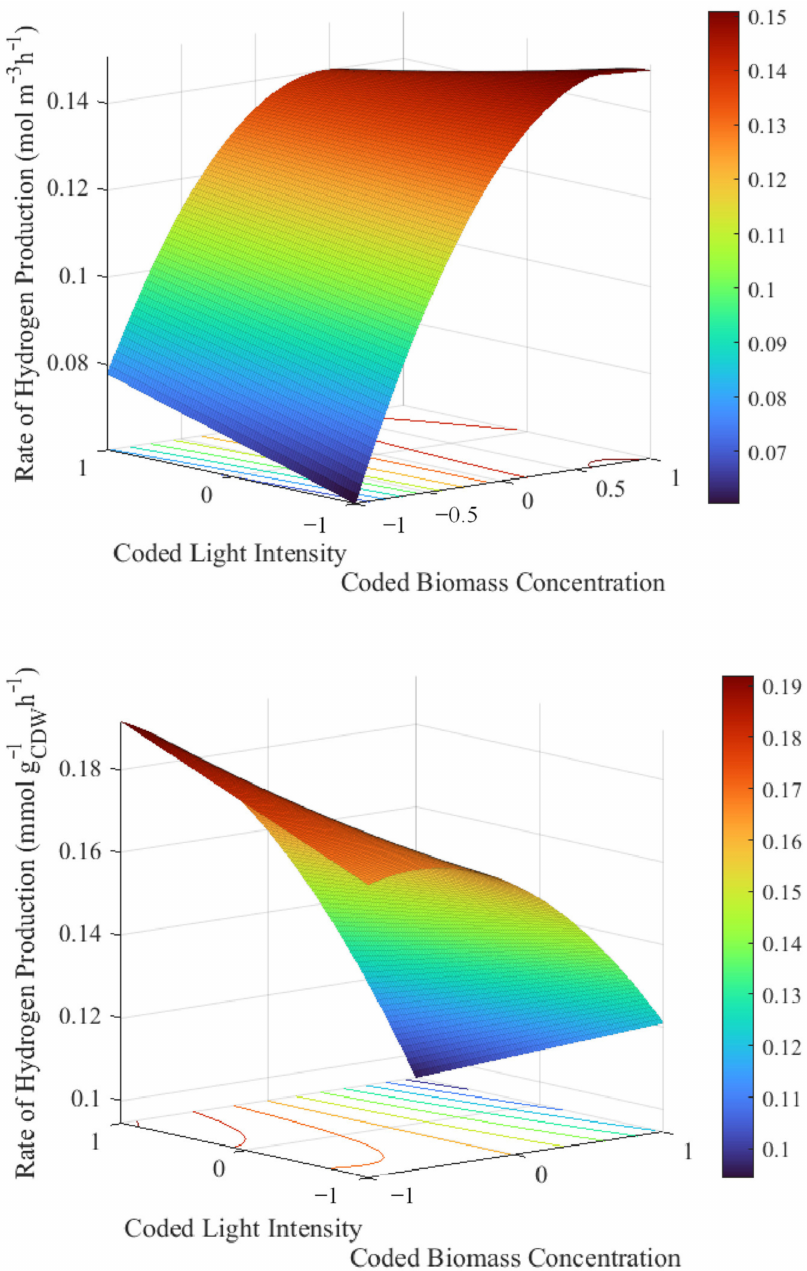
Figure 3. Response surface plots for the rate of hydrogen production per ( top ) reactor working volume; and ( bottom ) initial biomass concentration (models were plotted at the midpoint value of the third predictor variable not displayed on the graphs, i.e., at a cooling water inlet temperature of 19 ◦